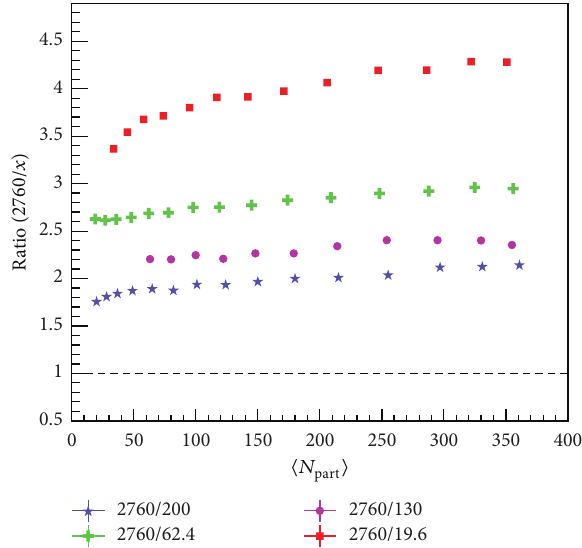
Figure 12: Ratio of charged particle density for different energies normalized per participant pair as a function of collision